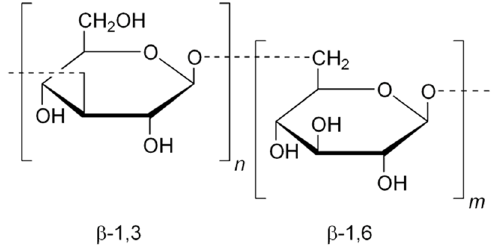
Figure 1. Chemical formula of β -glucans.